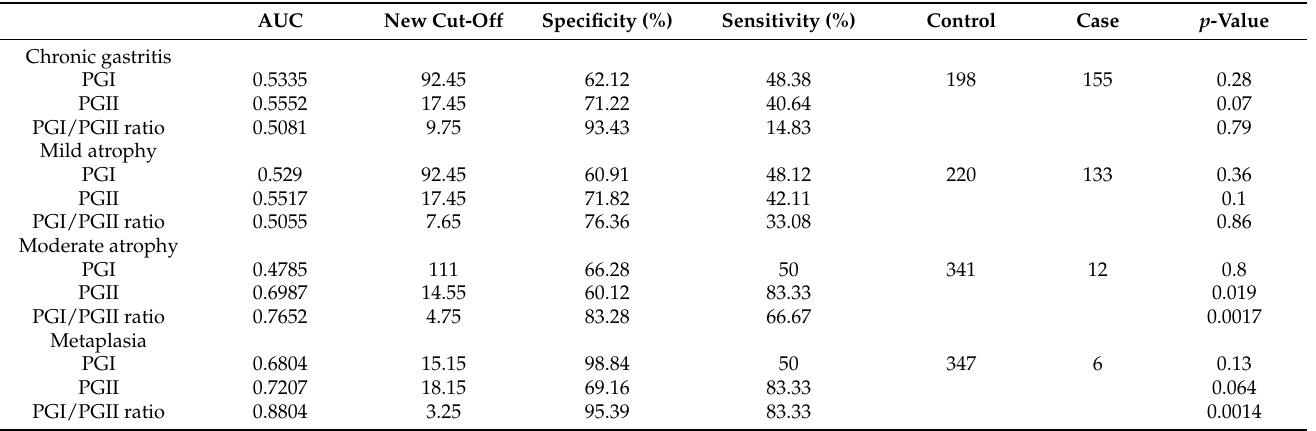
Table 5. Analysis of ROC and cut-off